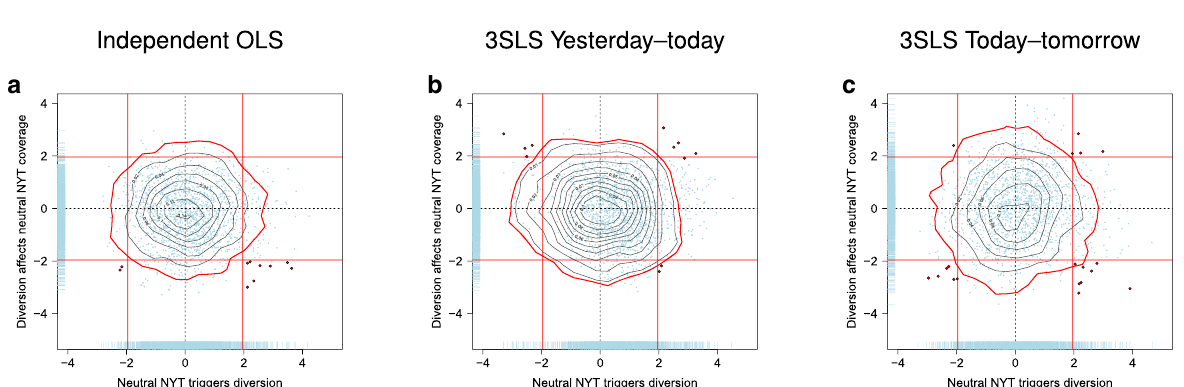
Fig. 6 The association between Brexit coverage in the NYT and diversion, and the association between diversion and subsequent Brexit coverage. For this analysis, only NYT articles that did not mention Russia or Mueller were considered ( N = 101, 435). Panel ( a ) is for two independent OLS models, panel ( b ) is a single 3SLS model in which suppression is modeled by relating yesterday ’ s tweets to today ’ s coverage, and c is a 3SLS model in which suppression is modeled by relating today ’ s tweets to tomorrow ’ s coverage. In each panel, the axes show jittered t -values of the regression coef fi cients for diversion (X- axis) and suppression (Y-axis). Each point represents diversion and suppression for one pair of words in the Twitter vocabulary. Red vertical and horizontal lines denote signi fi cance thresholds (±1.96). Word pairs that are triggered by coverage of the corresponding keyword ( p < 0.05) and affect subsequent coverage ( p < 0.05) are plotted in red. The gray contour lines in each panel show the distribution of points obtained if the timeline of tweets is randomized (red perimeter represents 95% cutoff, see “ Methods ” ). The blue rugs represent univariate